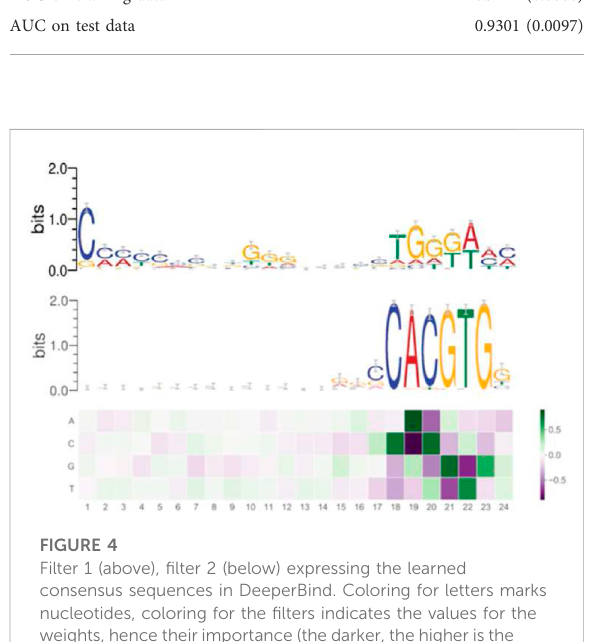
FIGURE 4 Filter 1 (above), fi lter 2 (below) expressing the learned consensus sequences in DeeperBind. Coloring for letters marks nucleotides, coloring for the fi lters indicates the values for the weights, hence their importance (the darker, the higher is the